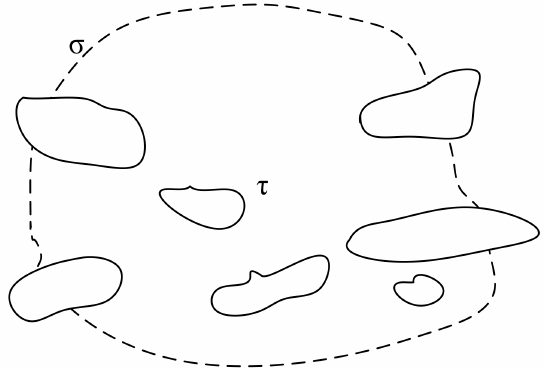
Figure 7. Flow of a two-phase liquid of any volume τ , limited by the surface σ